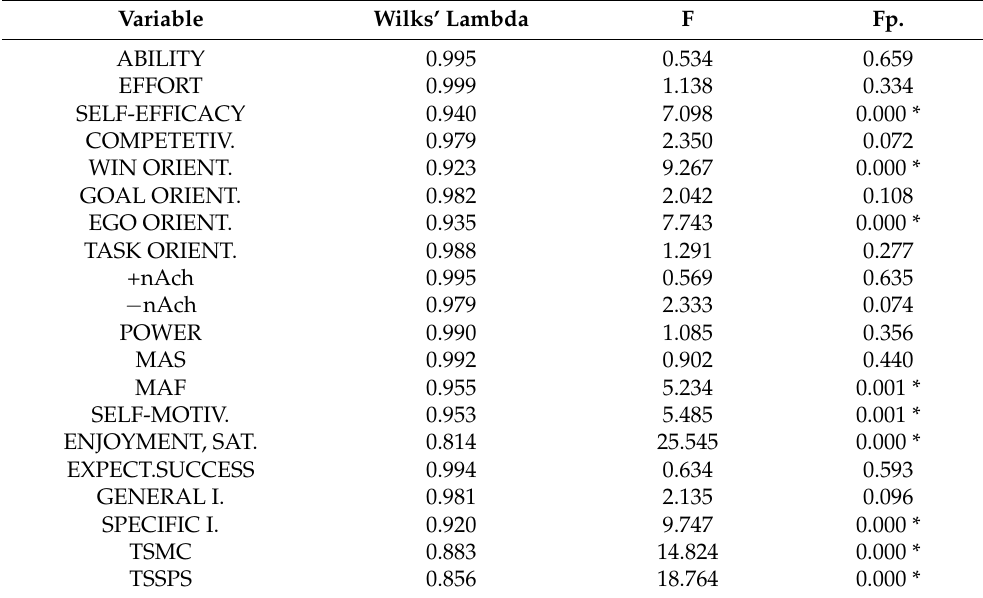
Table 2. Wilks’ Lambda and univariate